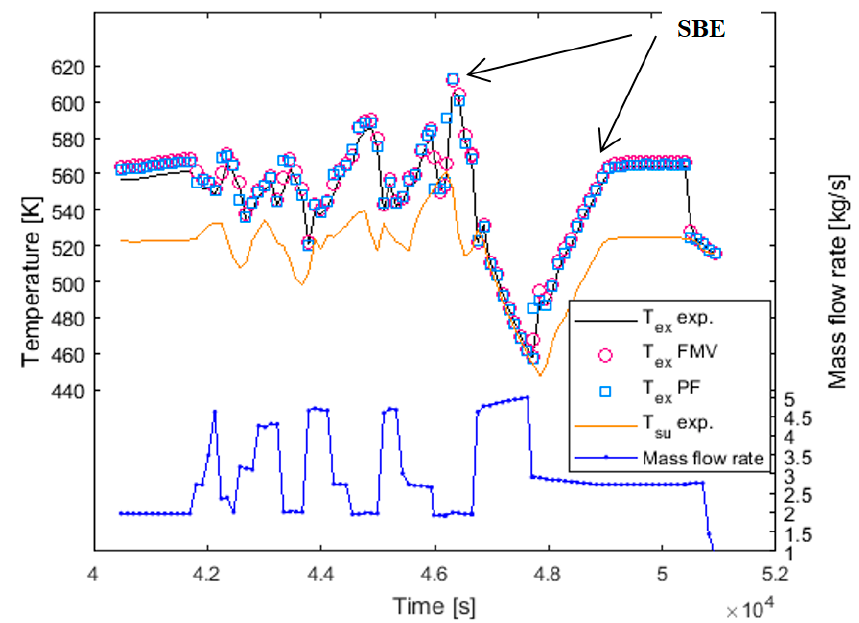
Figure 5. Experimental results performing one day versus plug flow and finite volume methods for a combination of inlet temperature, mass flow rate and solar beam step conditions.